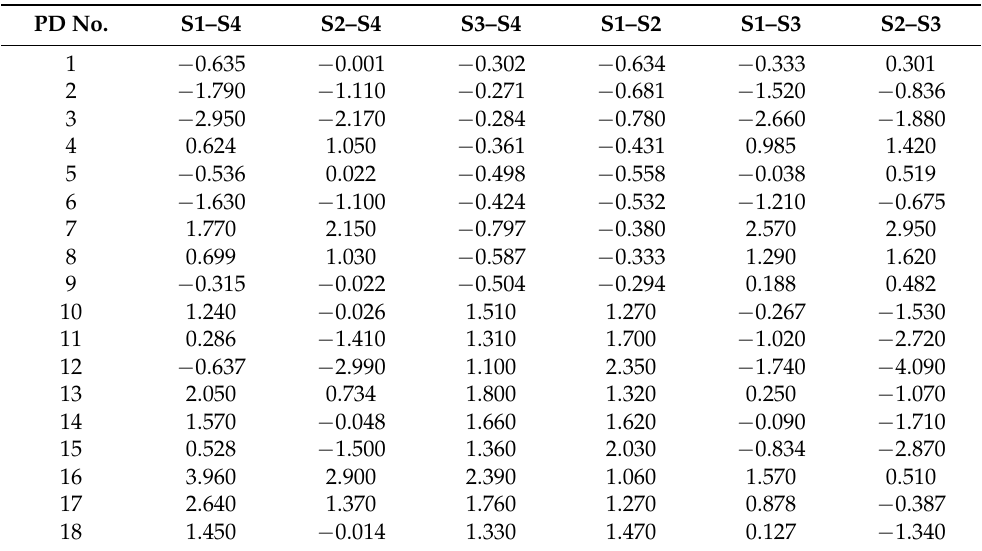
Table 3. Expected TDOA